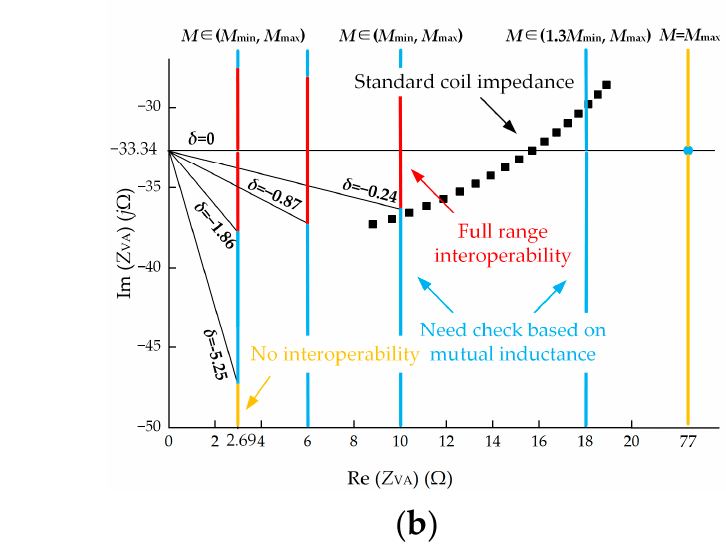
Figure 13. The reference impedance regions based on characteristic factors proposed by Harbin Institute of Technology ( a ) Region of Z GA ; ( b ) Region of Z VA .